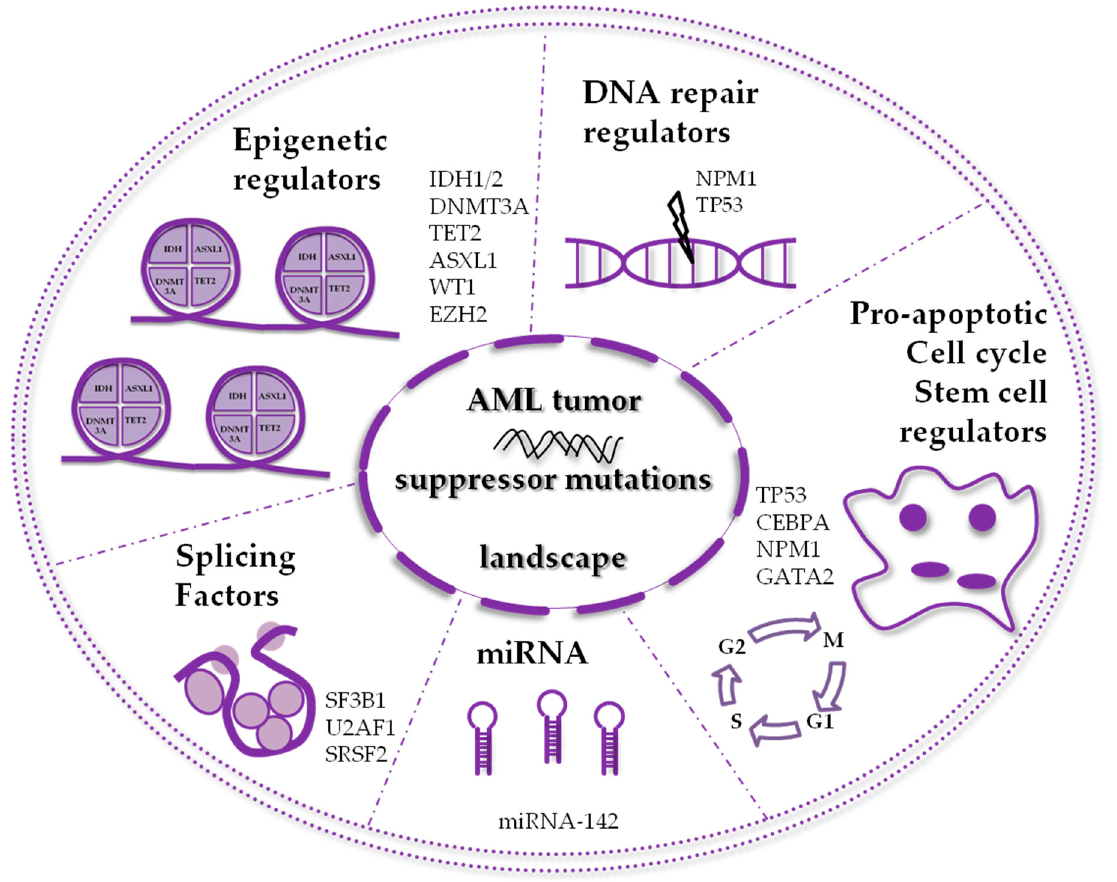
Figure 1. Schematic representation of the frequently mutated tumor suppressor proteins in acute myeloid leukemia (AML).